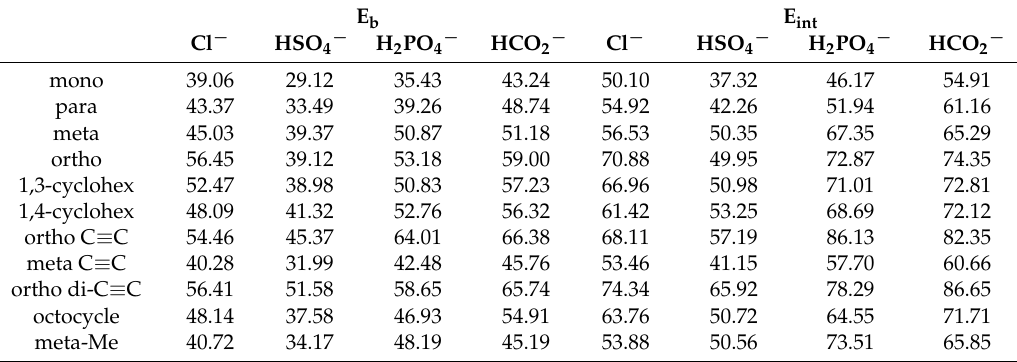
Figure 2. Complexes of Cl − , HSO 4 − , H 2 PO 4 − , and HCOO − with ( a ) monosubstituted and ( b ) para disubstituted phenyl rings. Distances in Å. Table 1. Binding (E b ) and interaction (E int ) energies (kcal/mol) for pairing of indicated Lewis acids with anions.